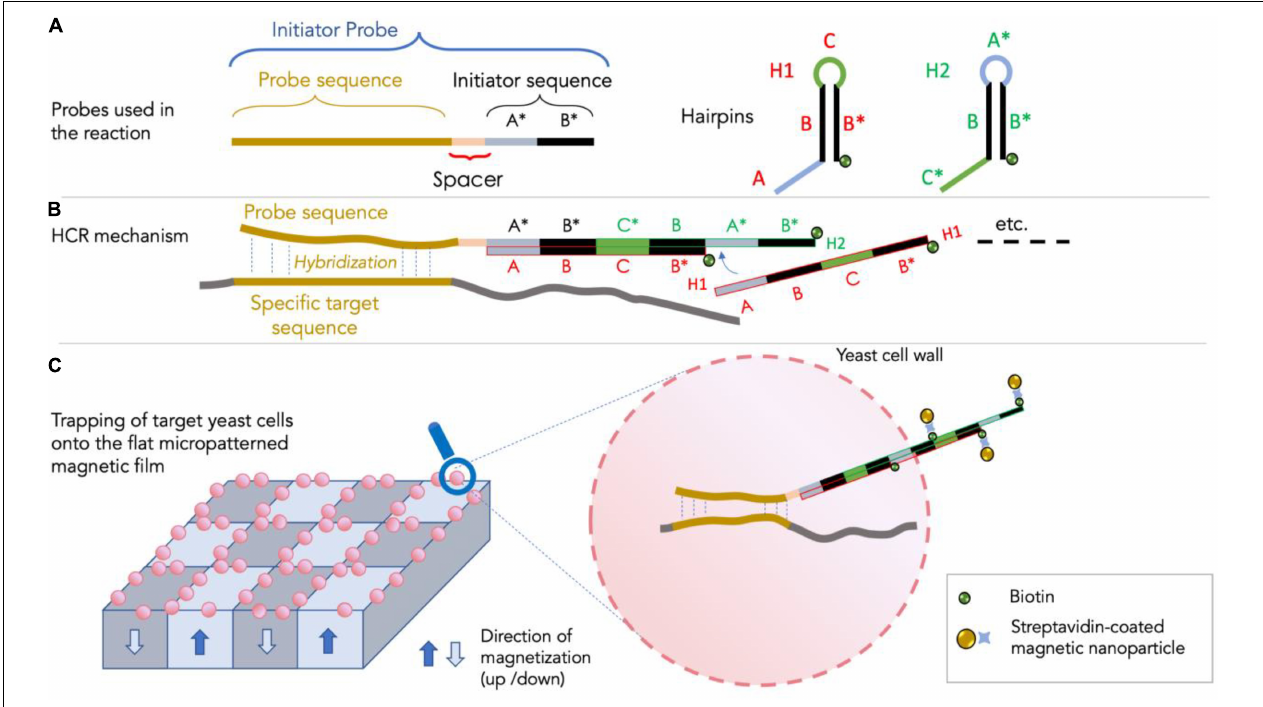
FIGURE 1 | The HCR-MISH approach (adapted from Royet et al., 2018). In panel (A) : the three probes (one specific initiator and two DNA hairpin H1 and H2 probes) used in the HCR-MISH approach are shown. Note that the specific initiator probe contains a specific sequence for the specific MISH hybridization, along with a spacer and an initiator sequence for the HCR amplification. The hairpin H1 and H2 probes are composed of three short sequences: (A–C) . In panel (B) : the HCR amplification step showing the overlapping H1 and H2 chain hybridization. In panel (C) : the magnetic labeling of the yeast cells as the ultimate result of the newly synthetized double-strand DNA composed of H1 and H2 overlapping probes, that are located outside the